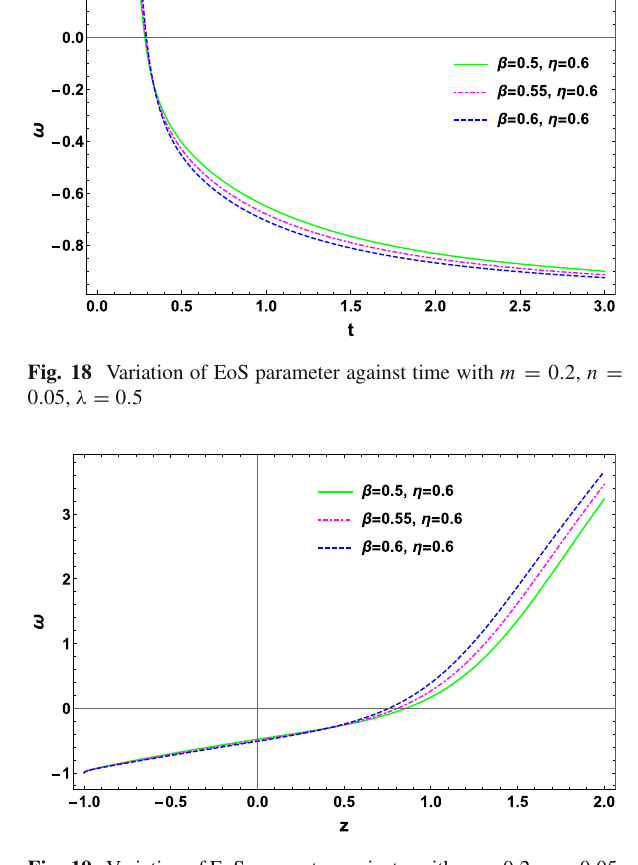
Ourcosmologicalsolutionsshowaveryhealthybehaviour and yield great cosmological models. Particularly, let us argue about the EoS parameter evolution. Figures 6, 12 and 18 show a remarkable feature. They present for the evolution of ω a scenario which is consistent with three different stages